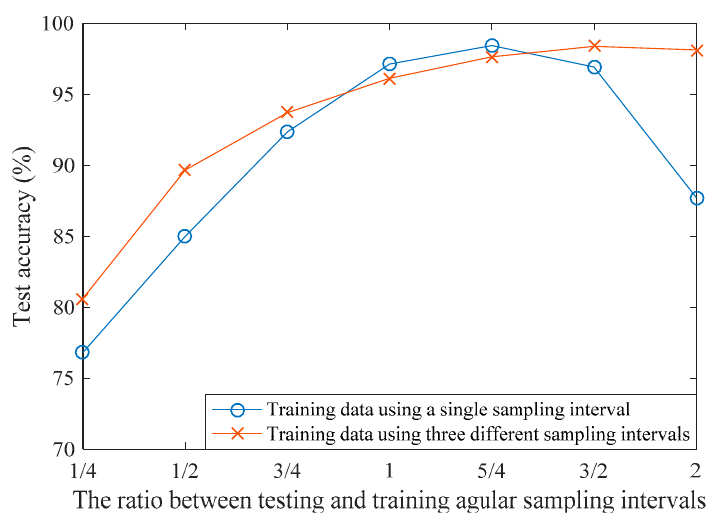
Figure 8. Recognition performance on different ratios between testing and training angular sampling intervals.